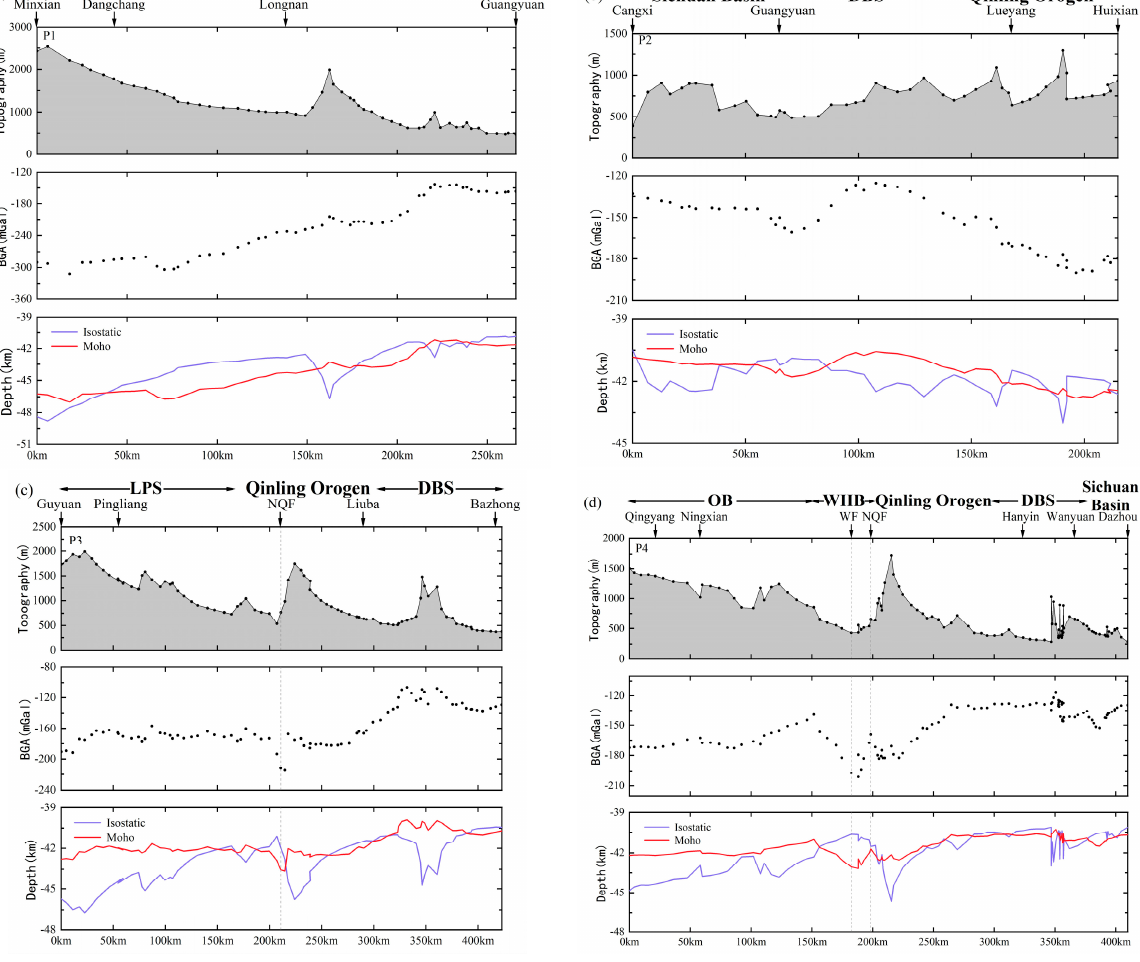
Figure 10. Topography, measured gravity anomalies, inverted Moho depth, and isostatic depth along four profiles; ( a ) P1, ( b ) P2, ( c ) P3, and ( d ) P4. Abbreviations are the same as those used in Figure 1.